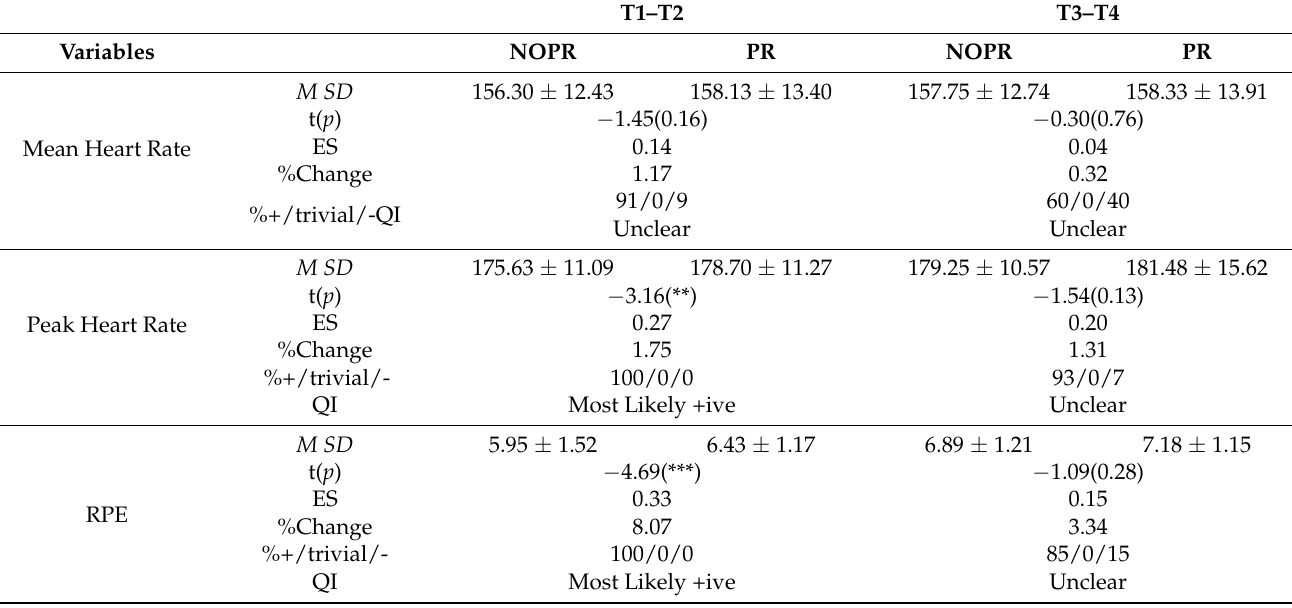
Table 2. Internal physical load results between pairs of tasks. T1–T2